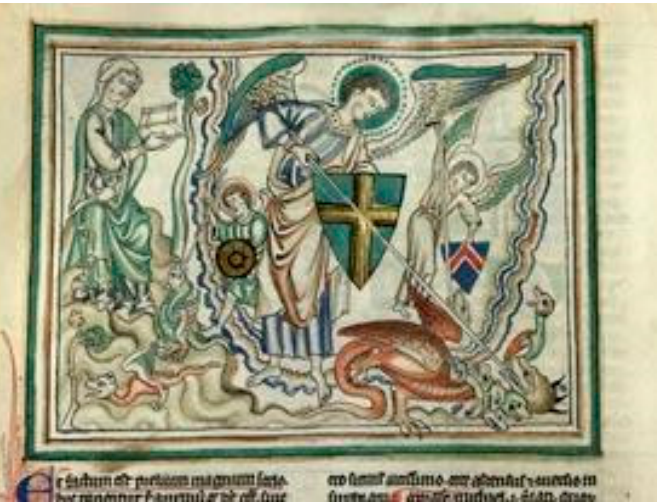
Figure 8. Cambrai Apocalypse (Le Labo—Cambrai Bibliothéque Municipale MS 422). Fol. 47 v , c. 1260, « cliché: IRHT-CNRS ».